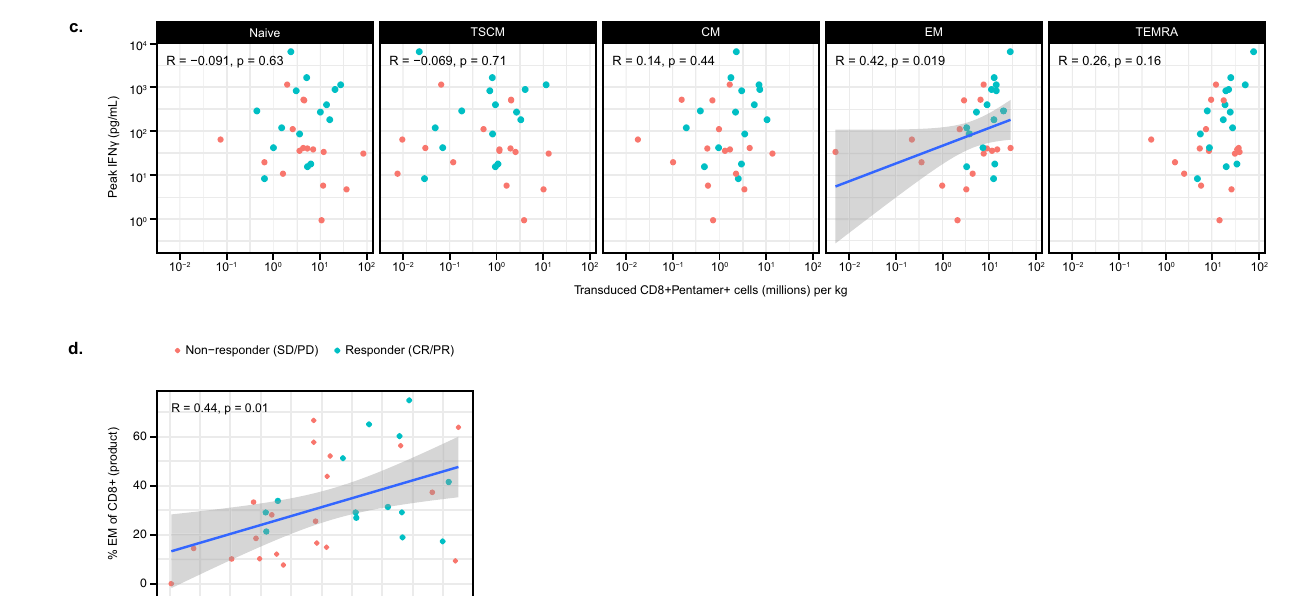
Fig. 3 | T-cell product enriched with activated, effector memory CD8 cells is associated with response. a Number of CD8+Pentamer+ cells/kg infused per memory phenotype in non-responders vs responders ( n =36 biologically inde- pendent samples). b , c Association of number of infused cells/kg per memory phenotypewithpeakcellexpansion( b )and peakIFN γ post-infusion( c )( n =34and 31 biologically independent samples for parts b and c respectively). Associations with EM cells are statistically signi fi cant with outlier at lowest infused cell counts removed — EM with Cmax ( R =0.42, p =0.016) and EM with IFN γ ( R =0.41, p =0.027). d Association of EM phenotype between apheresis and product ( n =34 biologically independent samples). Box plots depict median as horizontal line within box, with box bounds as the fi rst and third quartiles. Dots represent